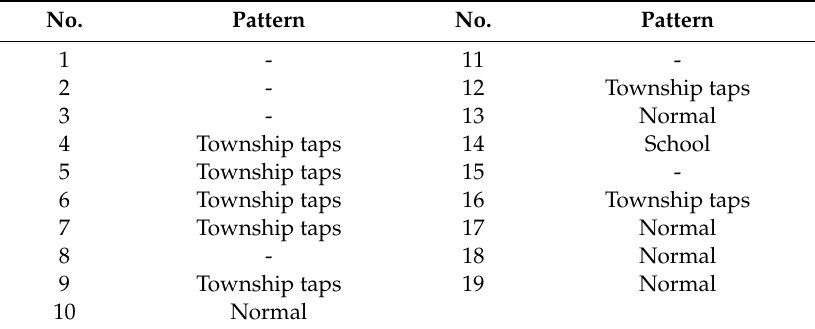
Figure 2. Typical weekday consumption patterns (normal households aggregated, township taps, schools and total of the three patterns) in Kampala water distribution systems [18]. Table 5. Demand pattern for each sampling points.